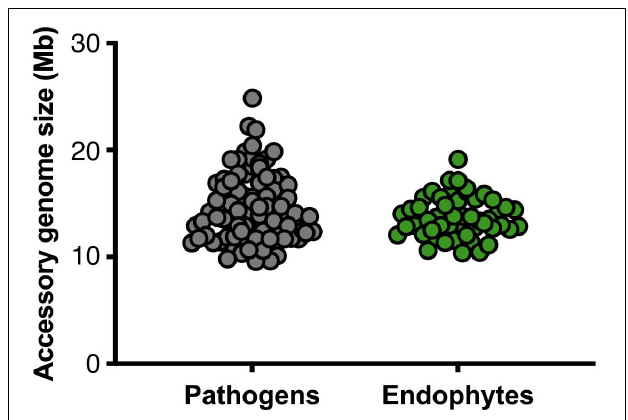
FIGURE 3 | Pathogens do not have larger accessory genomes than endophytes. The sizes of the accessory genomes – i.e., genomic regions that are present in less than 90% of the other 147 Fo genomes in the dataset – in million base pairs for pathogens (gray, left) and endophytes (green, right) ( p -value 0.16, non-parametric Mann–Whitney U test). Genome assemblies obtained by SMRT sequencing were excluded from the comparisons of accessory genome